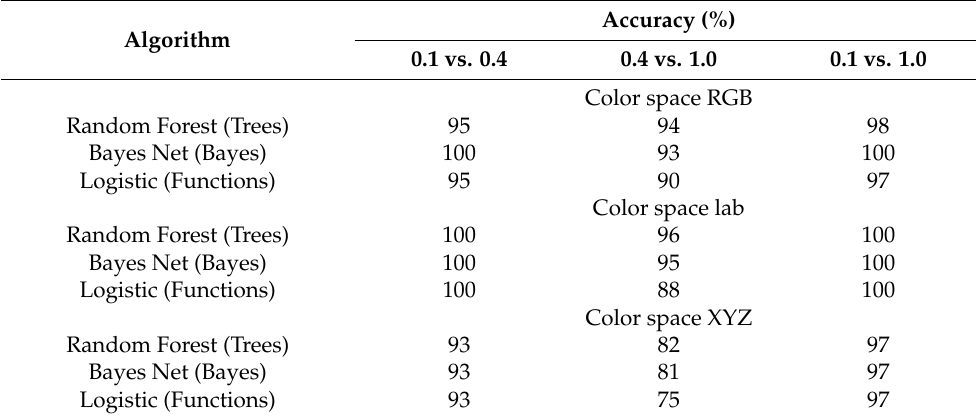
Table 6. The accuracy of distinguishing the ripening stages of ‘Royal Glory’ peaches based on sets of textures selected from individual color spaces of flesh